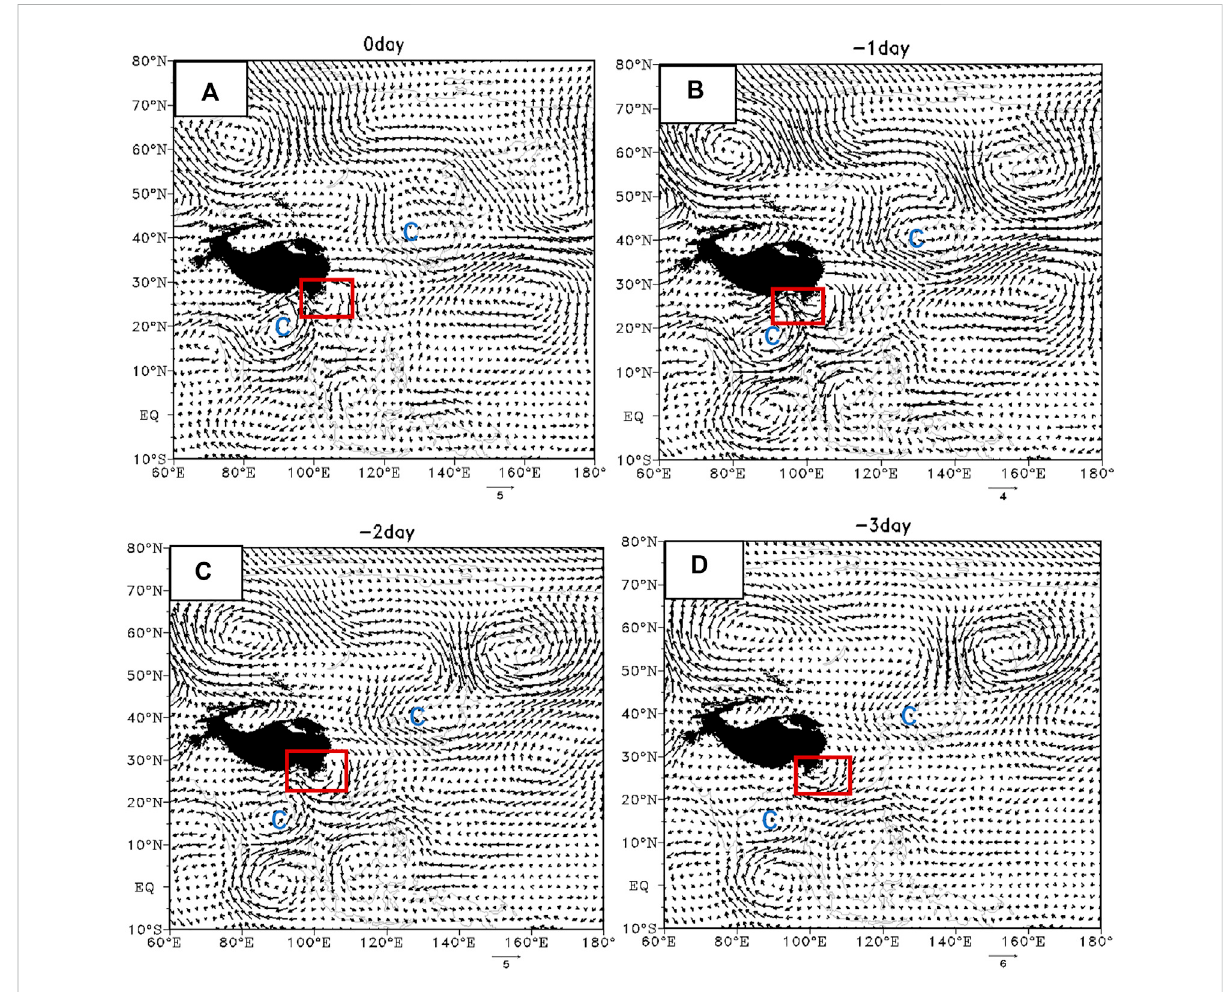
FIGURE 6 Evolution of the low-frequency (15 – 30 days) wind fi elds at 850 hPa from 3 days before the precipitation to 0 day after onset in Yunnan region, unit: m/s.